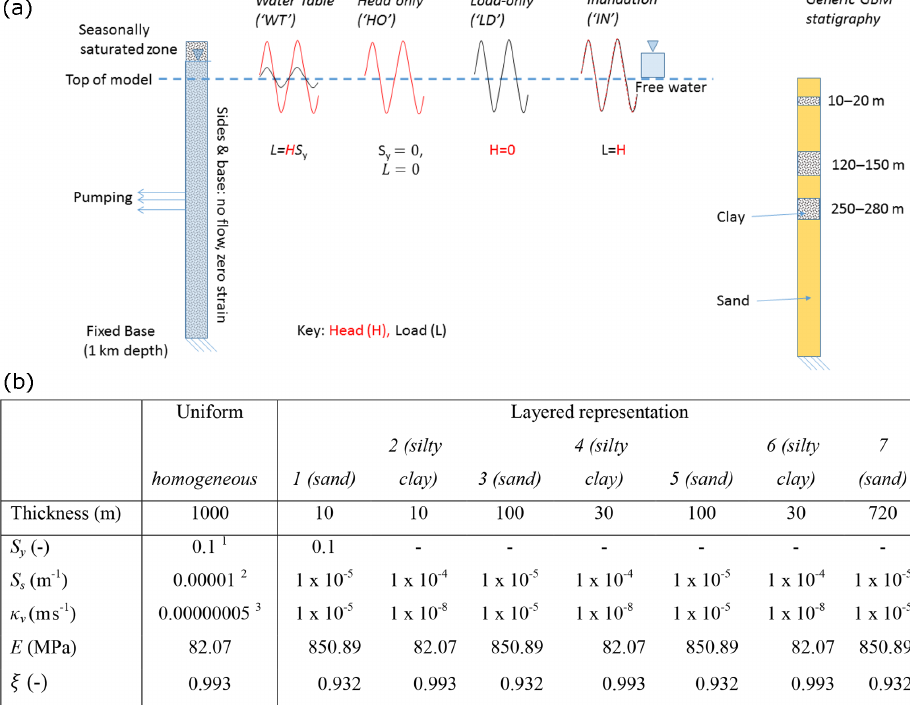
Figure 2. The 1-D model showing (a) the upper surface boundary conditions with head as red lines and mechanical load (weight) as black lines, expressed as metres of water, and a representative stratigraphy for the BAS underlying the GBM floodplains, with the profile depth being 1km; and (b) parameter values for the uniform and layered 1-D representations. Porosity is taken as 0.1 throughout; ν = 0 . 25; E and ξ are calculated using Eqs. (A3), (A4), and (A5). 1 Shamsudduha et al. (2011); 2 Burgess et al. (2017); 3 Michael and Voss